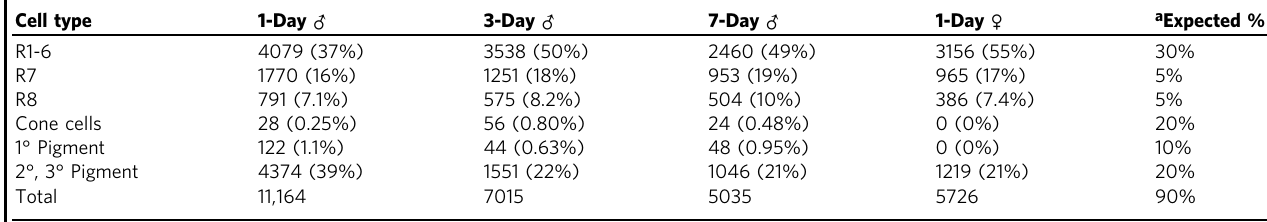
Table 2 Number of cells by cell type in each data